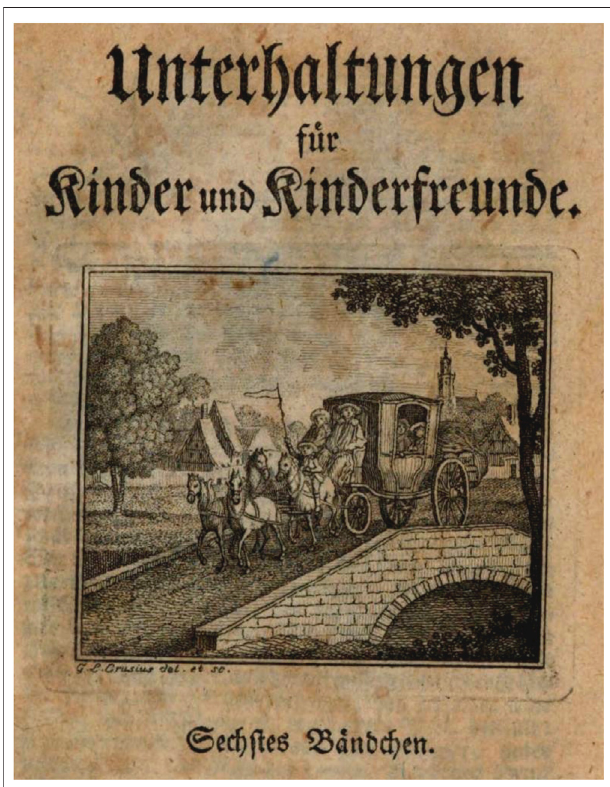
FIGURE 1 | Title page, Salzmann, Unterhaltungen für Kinder und Kinderfreunde , vol. 6 (Leipzig, 1783), detail. Courtesy of Bayerische Staatsbibliothek München, shelfmark Paed.pr. 2984-5/6, urn:nbn:de:bvb:12- bsb10760929-8.